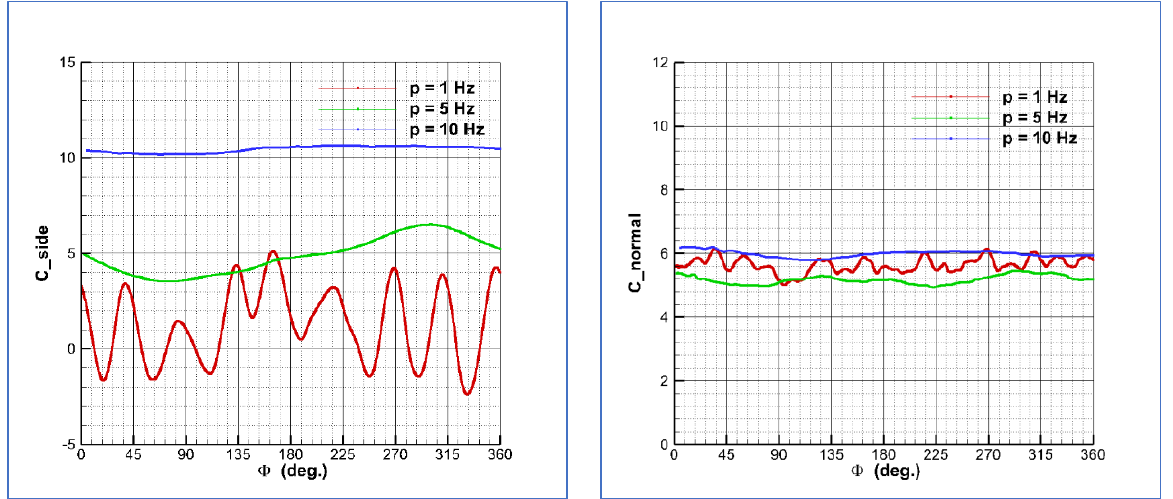
Figure 8. Side ( left ) and normal ( right ) force coefficients versus roll angle at the three different positive spin velocities. Last cycle. Ma = 0.2, Re =2 × 10 6 and α = 35 deg.